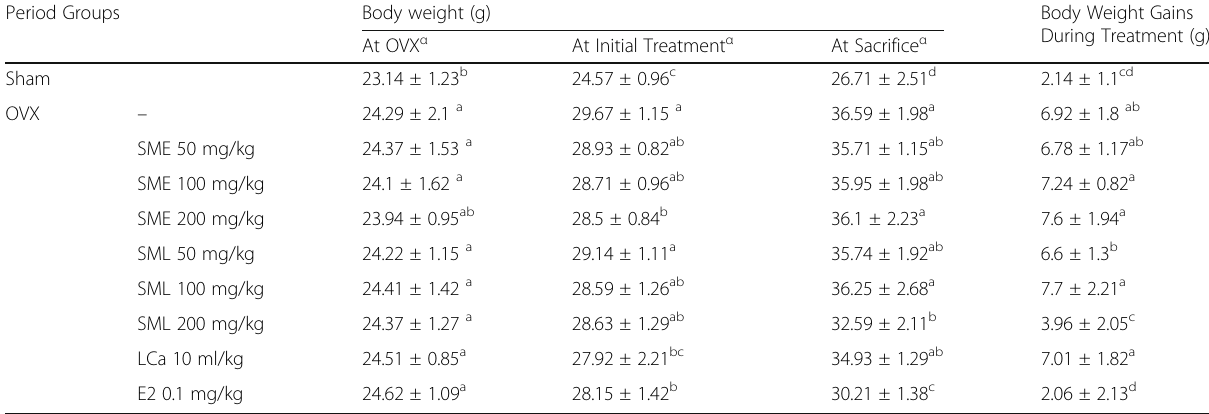
Table 1 Effects of SML on body weight in OVX mice Period